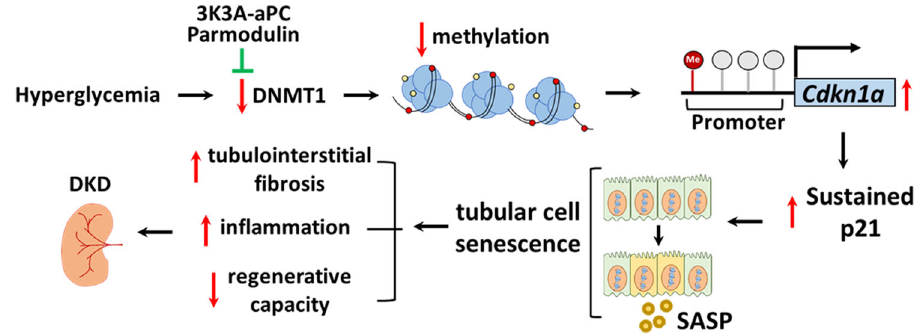
Fig. 9 | Proposed model summarizing the p21-dependent regulation of the hyperglycemic memory and possible interventions. Hyperglycemia suppresses DNMT1 expression in the tubular compartment, inducing hypomethylation of the p21promoter,p21expression,andtubularsenescence.Thelatterisassociatedwith